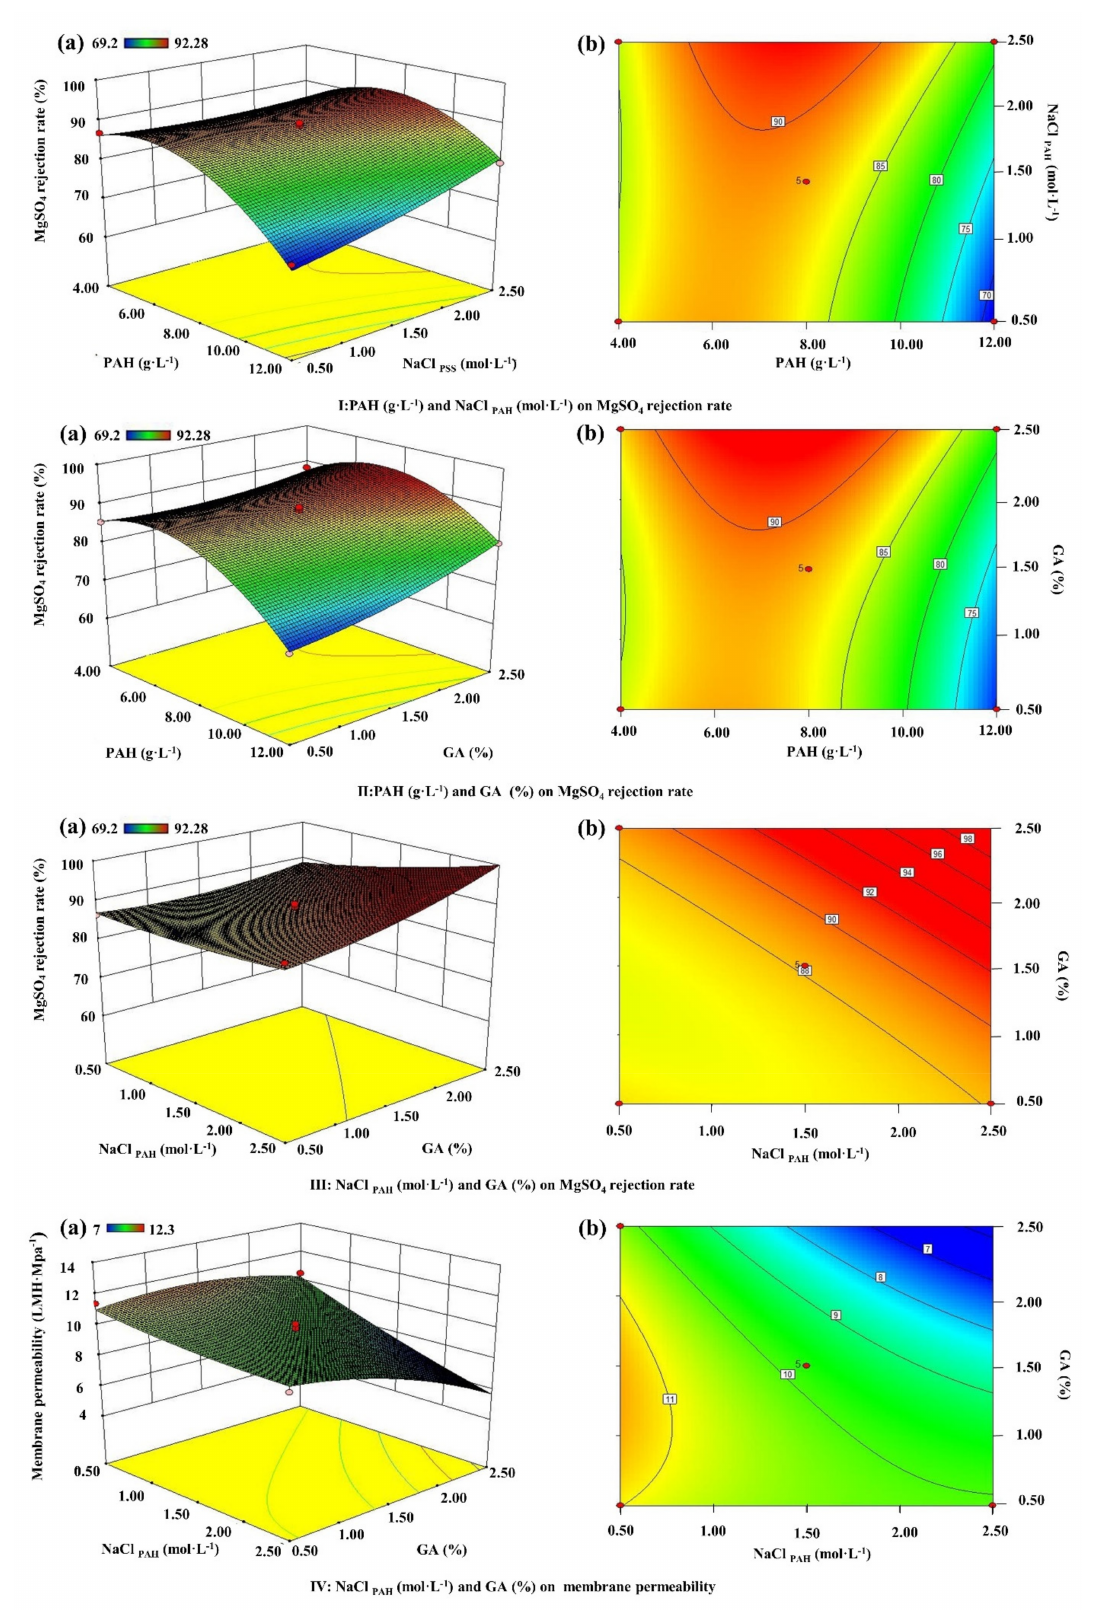
Figure 5. Response surface plots ( a ) and contour maps ( b ) of MgSO 4 rejection ( I – III ) and membrane permeability ( IV ) influenced by the interaction of different